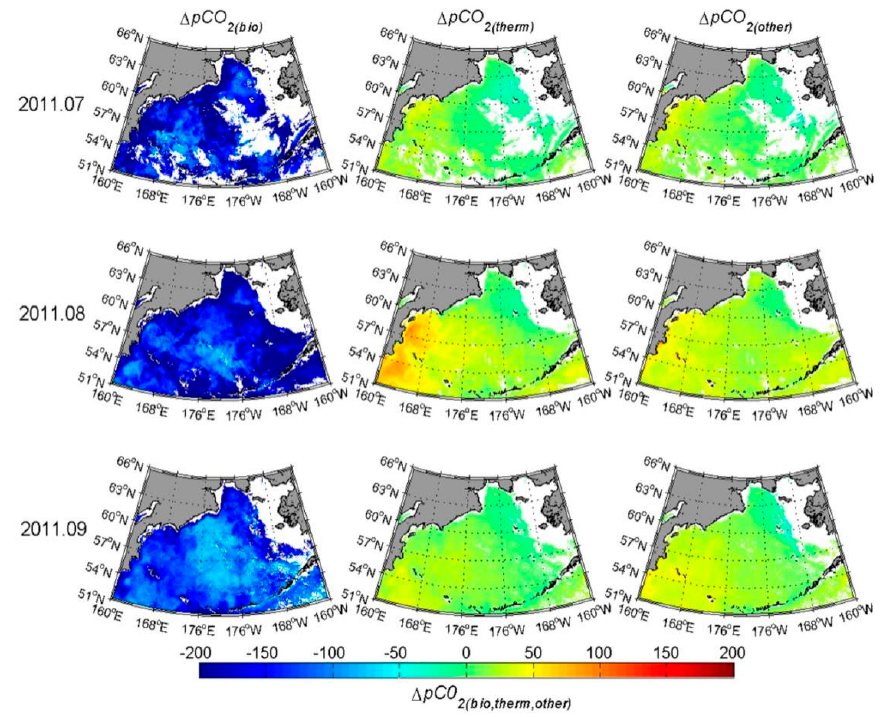
Figure 8. The contribution of biology ( Δ p CO 2(bio) ), temperature ( Δ p CO 2(therm) ), and other processes ( Δ p CO 2(other) ) on the sea surface p CO 2 variation in the 2011. The coastal areas shallower than 50 m depth are masked.